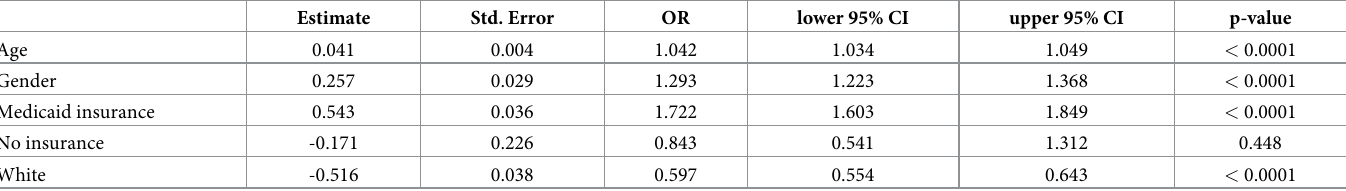
Table 2. Results from generalized linear mixed model for predicting obesity at the subject level.